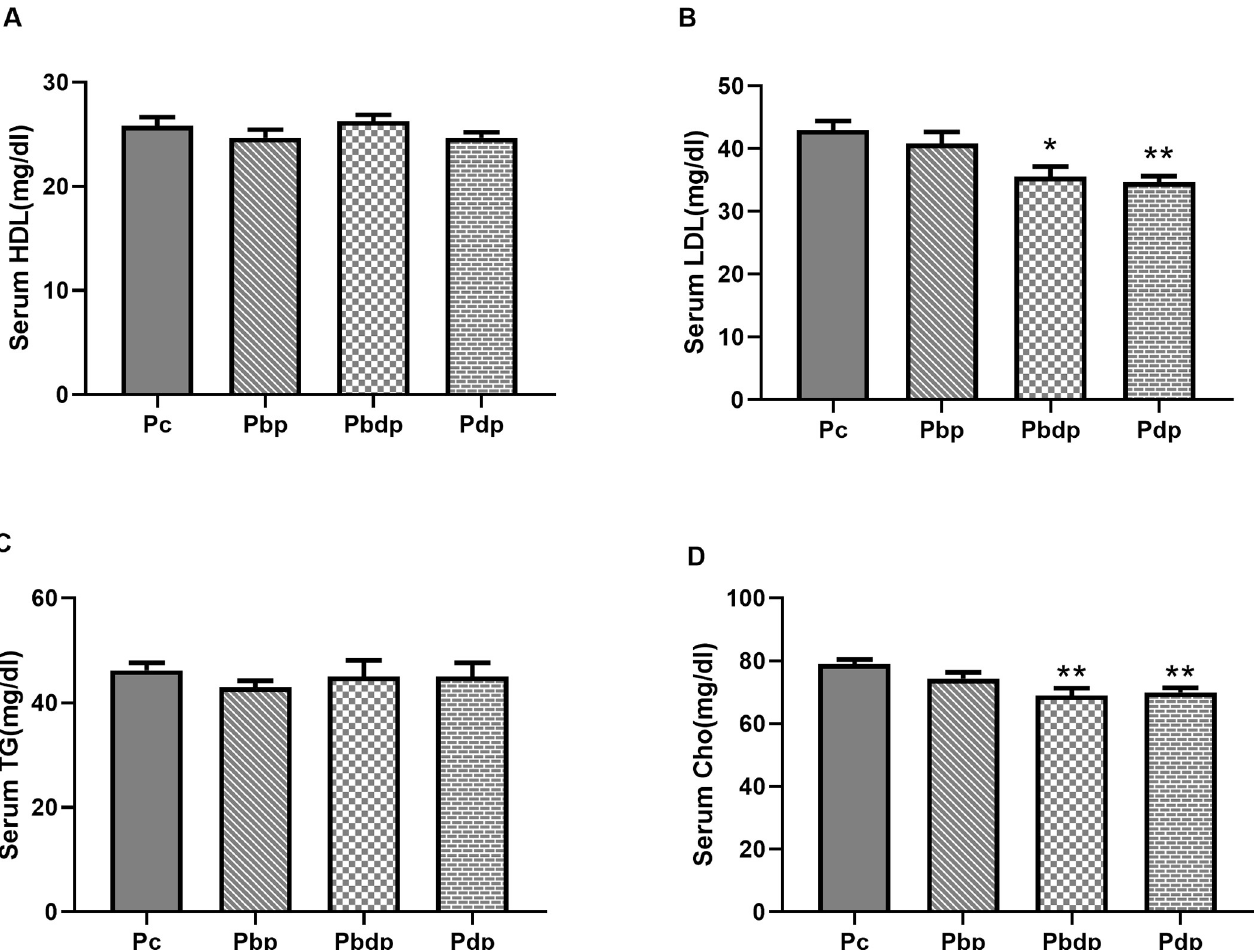
Fig 5. The comparison of lipid profile among the pup groups. (A) The serum level of HDL in male adult offspring groups. (B) the serum level of LDL in male adult offspring. (C) The serum level of TG in male adult offspring groups. (D) The serum level of Cho in male adult offspring groups. Abbreviations: P c group (n = 5), pups of sedentary mothers; P bp group (n = 6), pups of mothers who exercise only before pregnancy; P bdp group (n = 4), pups of mothers who exercise prior to and during pregnancy; P dp group (n = 6), pups of mothers who exercise only during pregnancy. Data presented as means ± S.E.M. � p < 0.05, �� p < 0.01 vs. Pup Control group. One-way ANOVA followed by Dunnett’s multiple comparisons test.